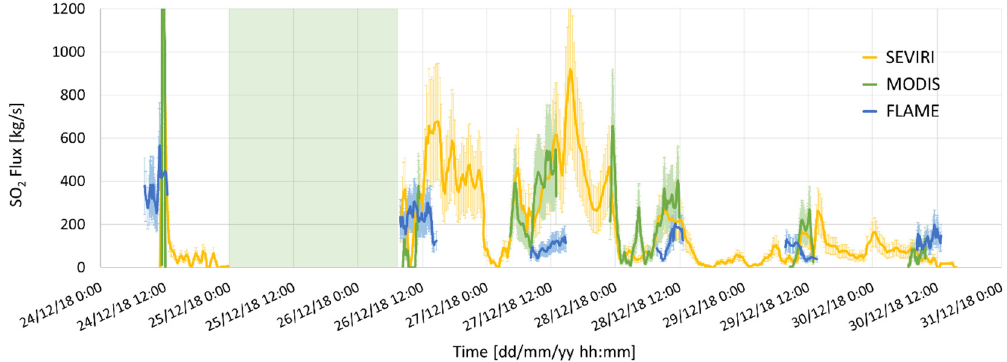
Figure 12. SO 2 flux obtained from SEVIRI (yellow), MODIS (green), and FLAME (blue). The yellow vertical bars represent the SEVIRI retrieval uncertainties.